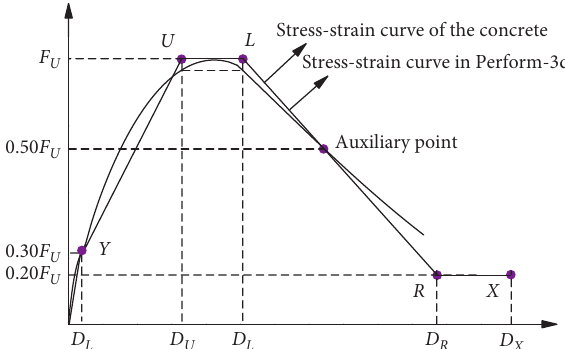
Figure 3: Rigid connection between the coupling beam and the shear wall.